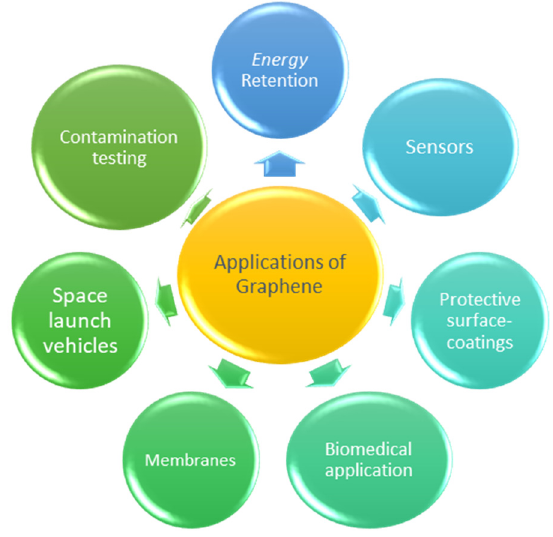
Figure 13. Schematic diagram of different applications of graphene.